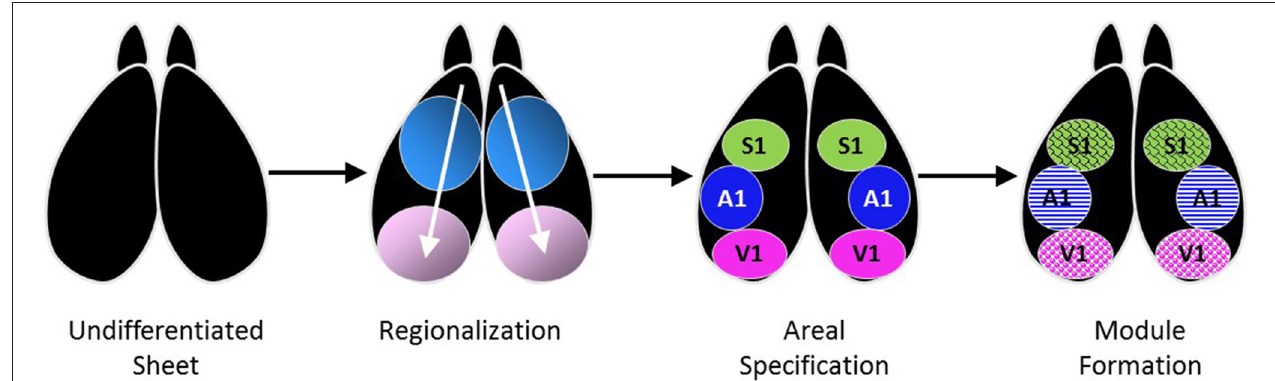
FIGURE 1 | Specification of primary sensory areas in cerebral cortex occurs gradually, starting with establishment of positional identity and polarity gradients that lead to regionalization, followed by formation of strict boundaries between cortical areas and the thalamocortical projections that bring in sensory information. Within each area, modules for special processing are distributed in a pattern that is characteristic for each area (Modified from Pallas et al., 2006, used with